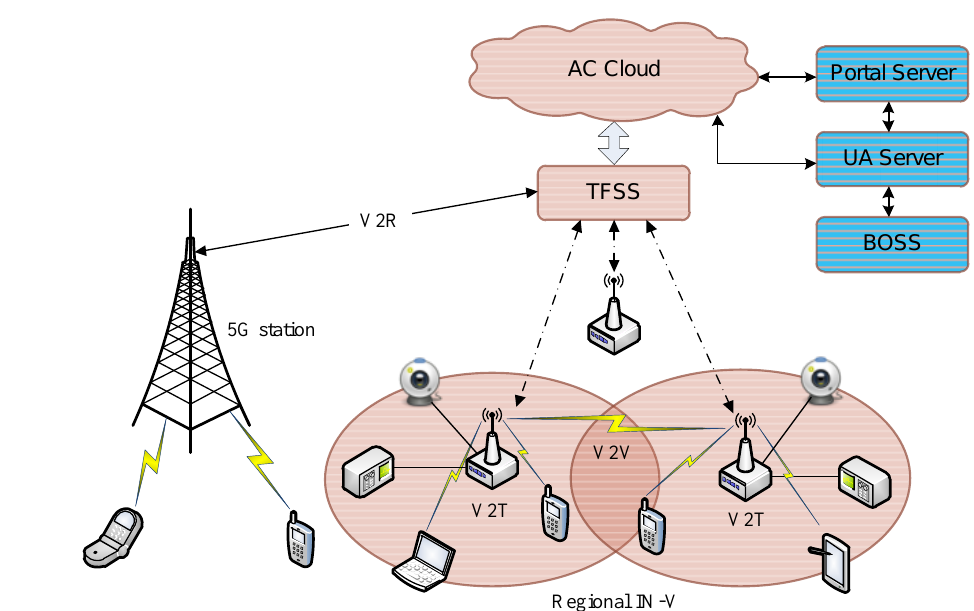
Figure 2. V2X-based service architecture.